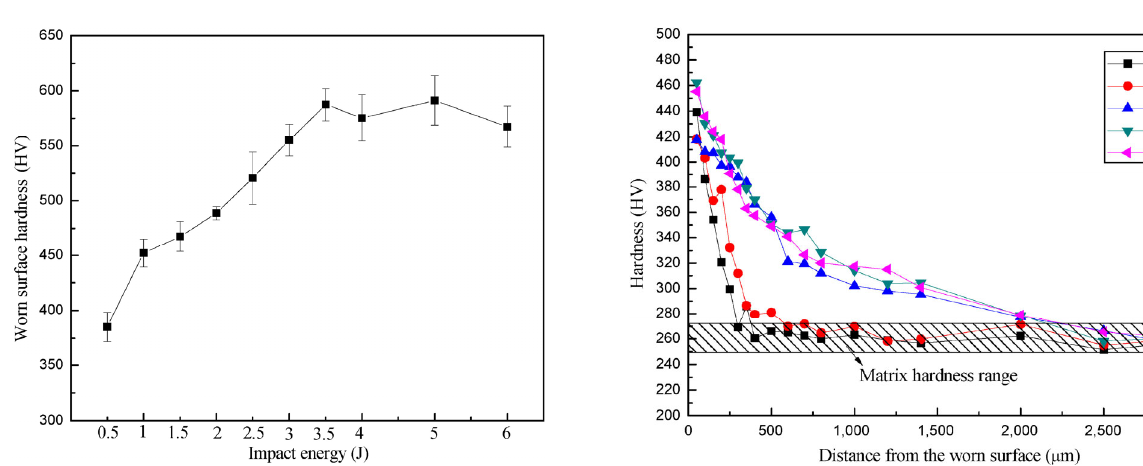
Fig. 3 The topography of the worn surface: (a), (b), (c), (d), and (e) are at 1 J, 1.5 J, 2.5 J, 3.5 J, and 5 J,